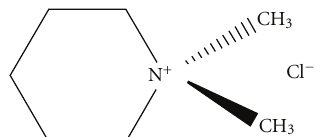
Figure 1: Structural formula of 1,1-dimethylpiperidine